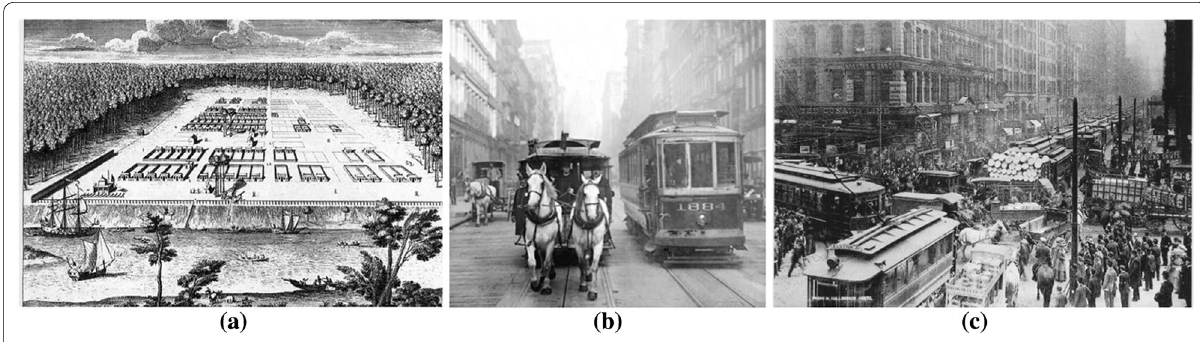
Fig. 1 Early American city and industrialization (Trancik 1986; Hall 1996). a Savanna Georgia, Oglethorpe, 1733. b Streetcars and carriages, 1890. c Industrialization, Chicago,